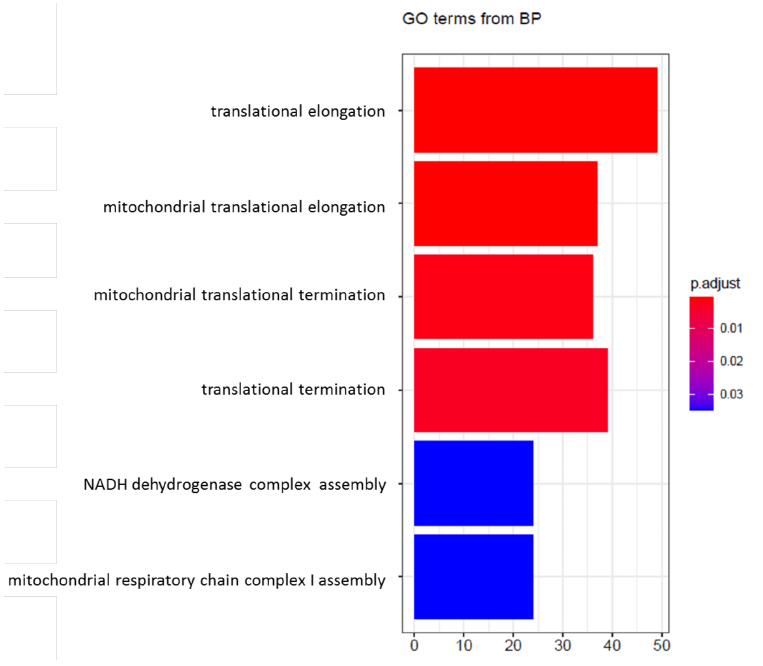
Figure 3. GO terms from biological processes found to be mainly modified following the gene enrichment analysis.